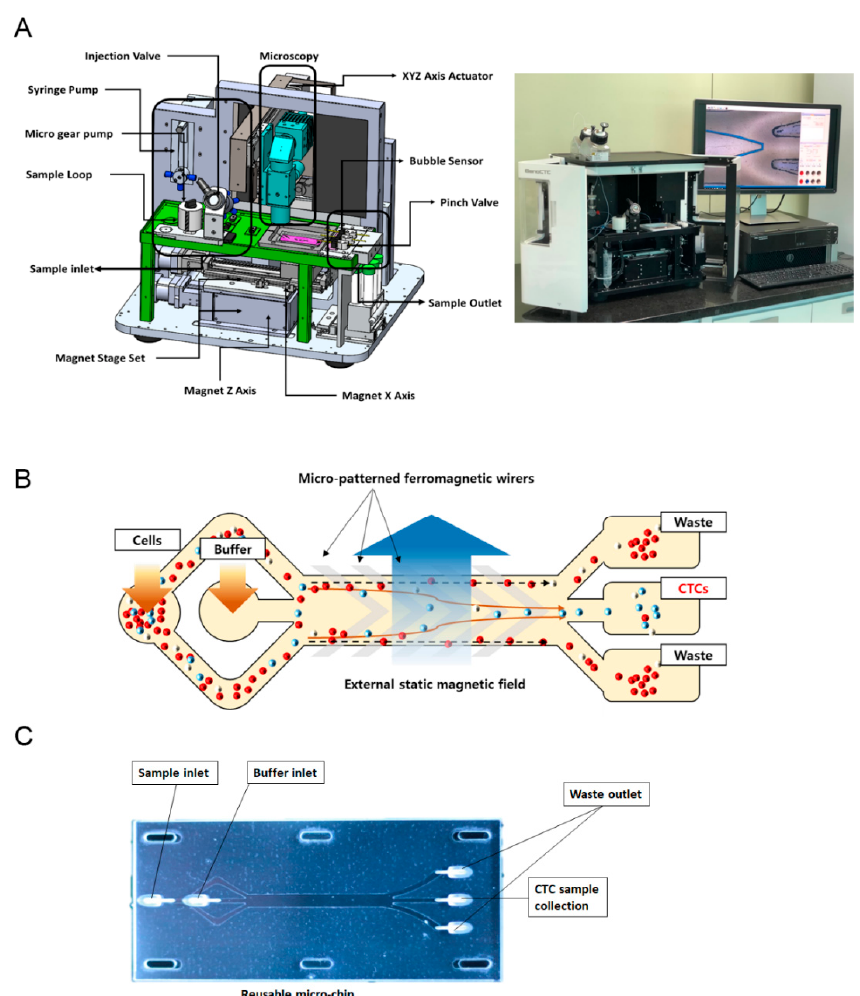
Figure 1. Schematic representation of GenoCTC and GenoChip: ( A ) Schematic diagram showing the microfluidic system of GenoCTC. All components that produce the microfluidic force and magnetic field for isolating circulating tumor cells (CTCs) are indicated. ( B ) Graphical image of GenoChip. CTCs are isolated by a magnetic gradient-based force using lateral magnetophoresis. The microfabricated ferromagnetic stripes generate a magnetic trap so that cells bound to a sufficient number of magnetic beads are trapped over the magnetic stripes and move along the stripe direction, rather than parallel to the fluid flow. ( C ) Actual image of the updated disposable chip. High capture efficiency, high throughput, and high isolation purity, while preserving cell viability, are critical factors to be considered in evaluating the performance of a CTC isolation system [22,23]. Unlike many studies in which the results were evaluated on the basis of separation or recovery rates according to an imprecise concept, our method enables the accurate calculation of the efficiency of cell isolation. A detailed evaluation of the performance of GenoCTC is presented below. The recovery rate was calculated by comparing the total cell input with the total cell output. Recovery (%): (cid:3016)(cid:3048)(cid:3047)(cid:3043)(cid:3048)(cid:3047) (cid:3030)(cid:3032)(cid:3039)(cid:3039)(cid:3046) ((cid:3024)(cid:3028)(cid:3046)(cid:3047)(cid:3032)(cid:2878)(cid:3004)(cid:3021)(cid:3004)(cid:3046)(cid:2878)(cid:3024)(cid:3003)(cid:3004) (cid:3036)(cid:3040)(cid:3043)(cid:3048)(cid:3045)(cid:3036)(cid:3047)(cid:3036)(cid:3032)(cid:3046)) (cid:3021)(cid:3042)(cid:3047)(cid:3028)(cid:3039) (cid:3010)(cid:3041)(cid:3043)(cid:3048)(cid:3047) (cid:3030)(cid:3032)(cid:3039)(cid:3039)(cid:3046) × 100 (1) The separation rate was determined by calculating the proportion between untargeted cells— termed wastes—and EPCAM-positive cells, which were our target cells. The target cell compartment